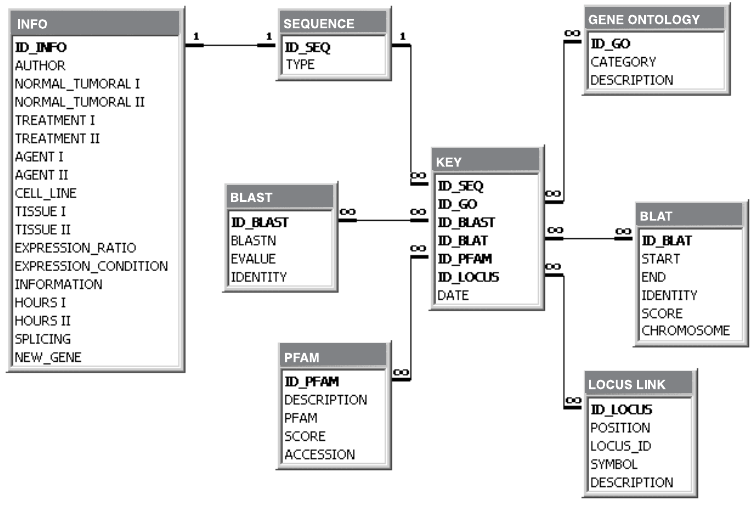
Figure 2 . The structure of GATO. The database is composed of a table called KEY, which stores the case history. The INFO Table stores experimental conditions, and SEQUENCE stores the pointer to submitted file and the type, whether it is a chromatogram or a FASTA file. This structure facilitates the insertion of new tools and the maintenance of annotation